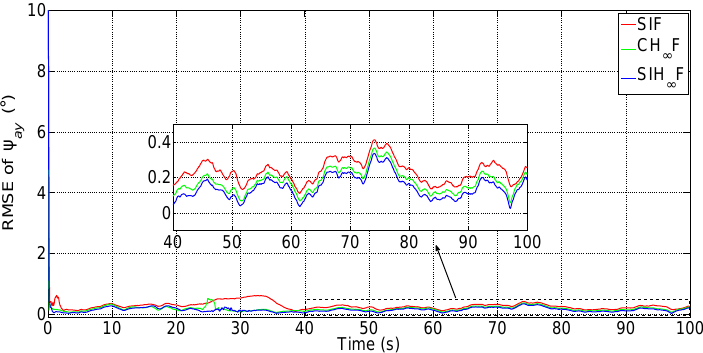
Figure 6. RMSE of ψ ay (the subfigure is the magnification of the estimation result during 40 s–100 s).